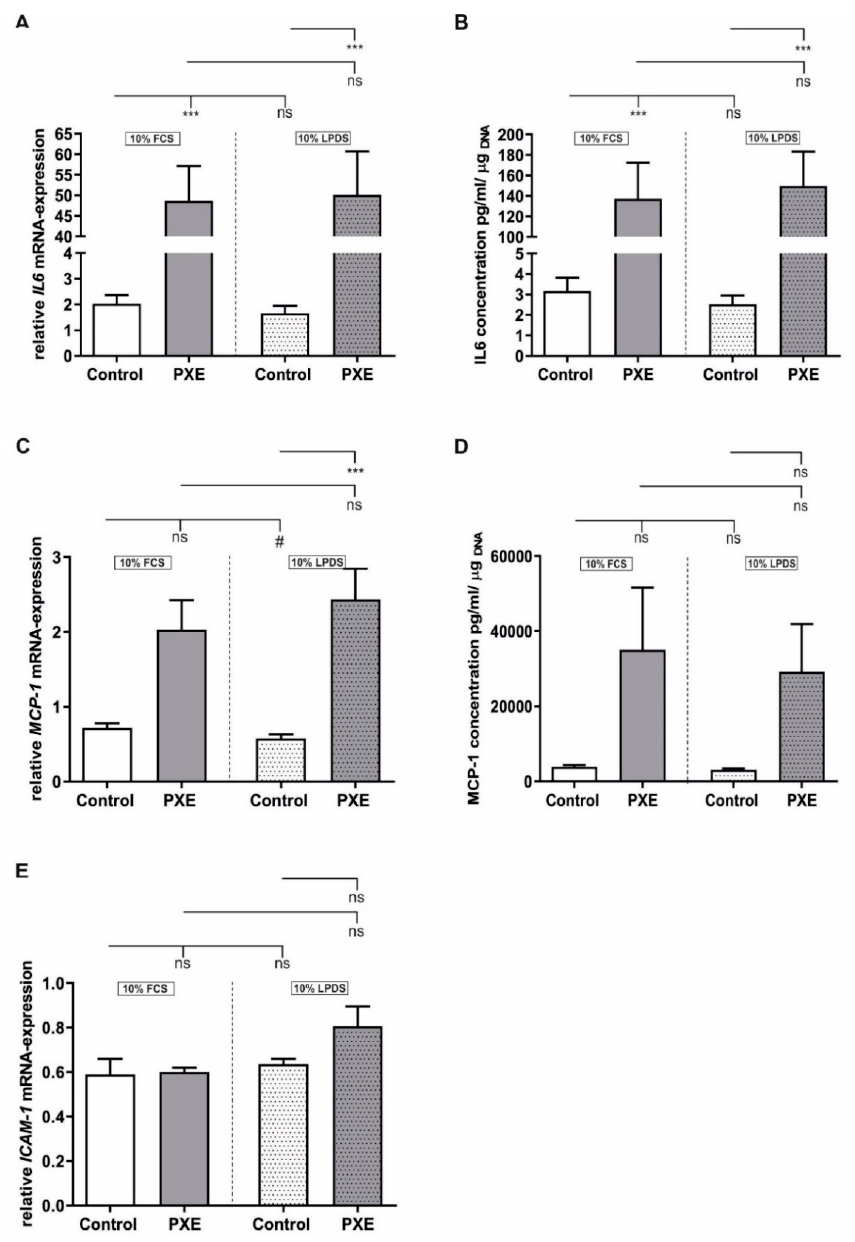
Figure 4. Relative mRNA-expression und protein expression of proinflammatory factors in PXE fibroblasts and NHDF. Fibroblasts were cultivated for 21 d in medium with 10% FCS or 10% LPDS. ( A ) Relative IL6 mRNA-expression of PXE fibroblasts (gray, n = 3) and NHDF (white, n = 3). ( B ) IL6 protein concentration in supernatants of PXE fibroblasts (gray, n = 3) and NHDF (white, n = 3). ( C ) Relative MCP1 mRNA-expression of PXE fibroblasts (gray, n = 3) and NHDF (white, n = 3). ( D ) MCP1 protein concentration in supernatants of PXE fibroblasts (gray, n = 3) and NHDF (white, n = 3). ( E ) Relative ICAM1 mRNA-expression of PXE fibroblasts (gray, n = 3) and NHDF (white, n = 3). Data are shown as mean ± SEM. Control/PXE: *** p ≤ 0.001; ns p > 0.05. 10% FCS/10% LPDS: # p ≤ 0.05; ns p > 0.05.